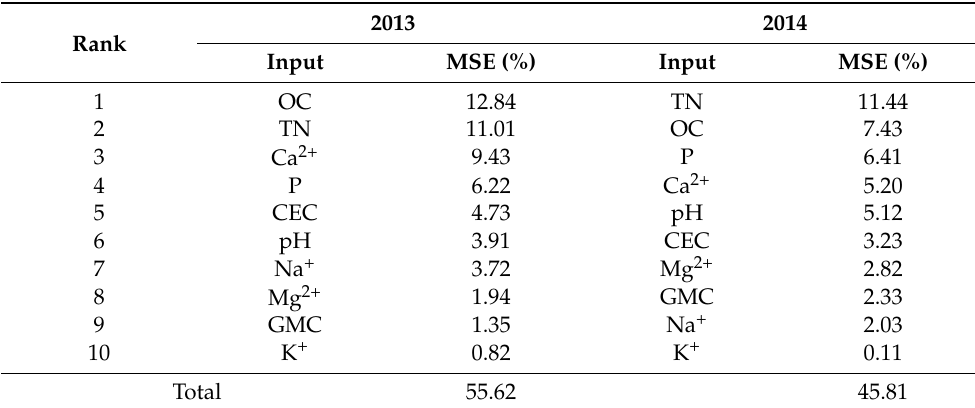
Table 4. Calculated variable importance score (MSE) of the yield prediction obtained with the random forest (RF) model, indicating the contribution of each soil property on crop yield in 2013 and 2014.